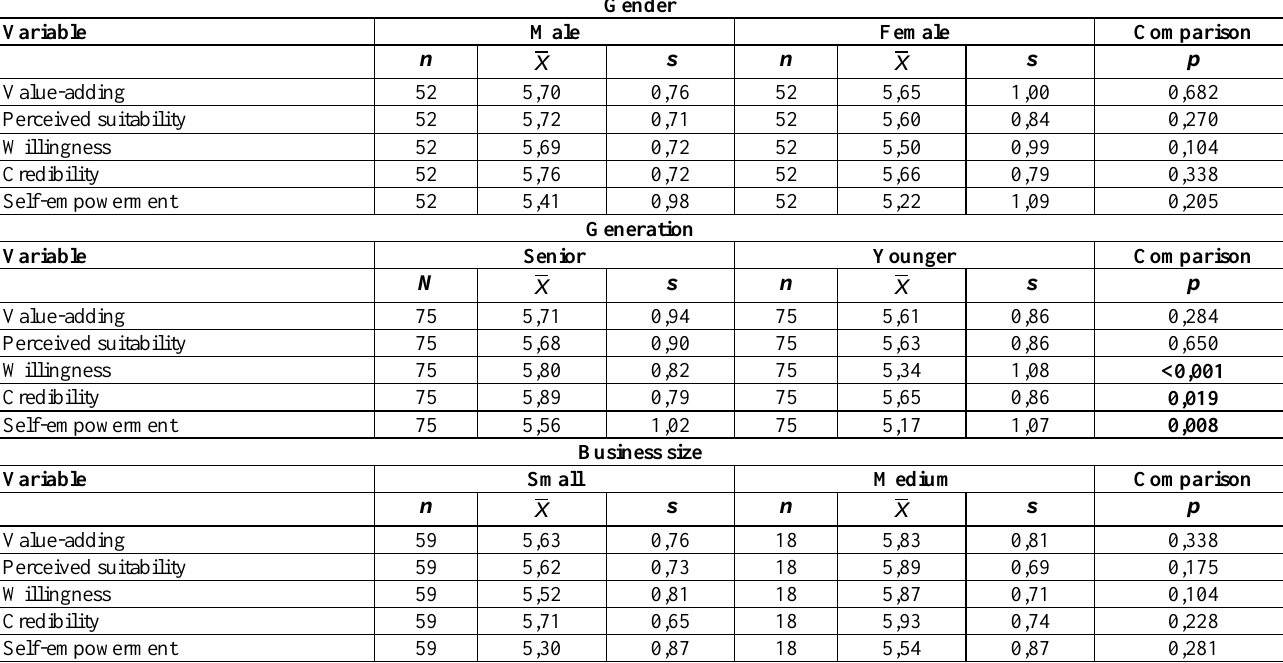
Table 4: The results of the differences in means between the variables for different demographic variables Gender Variable Male Female